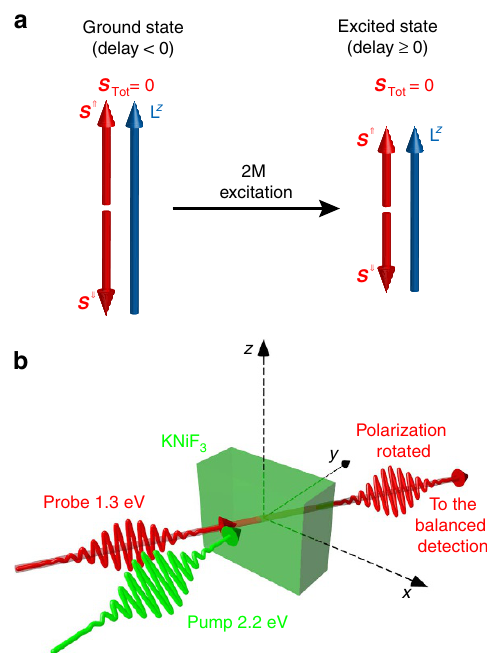
Figure 1 | 2M mode and experimental configuration. ( a ) The 2M